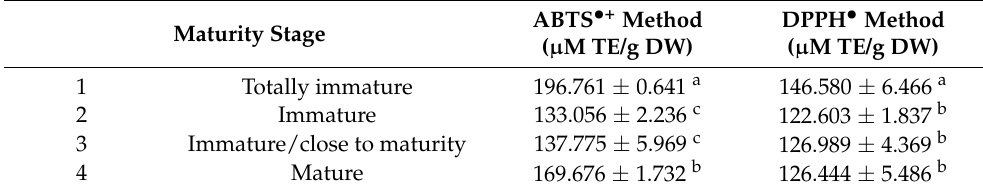
Table 6. Antioxidant capacity of methanolic extracts of Vaccinium stenophyllum Steud. fruits during